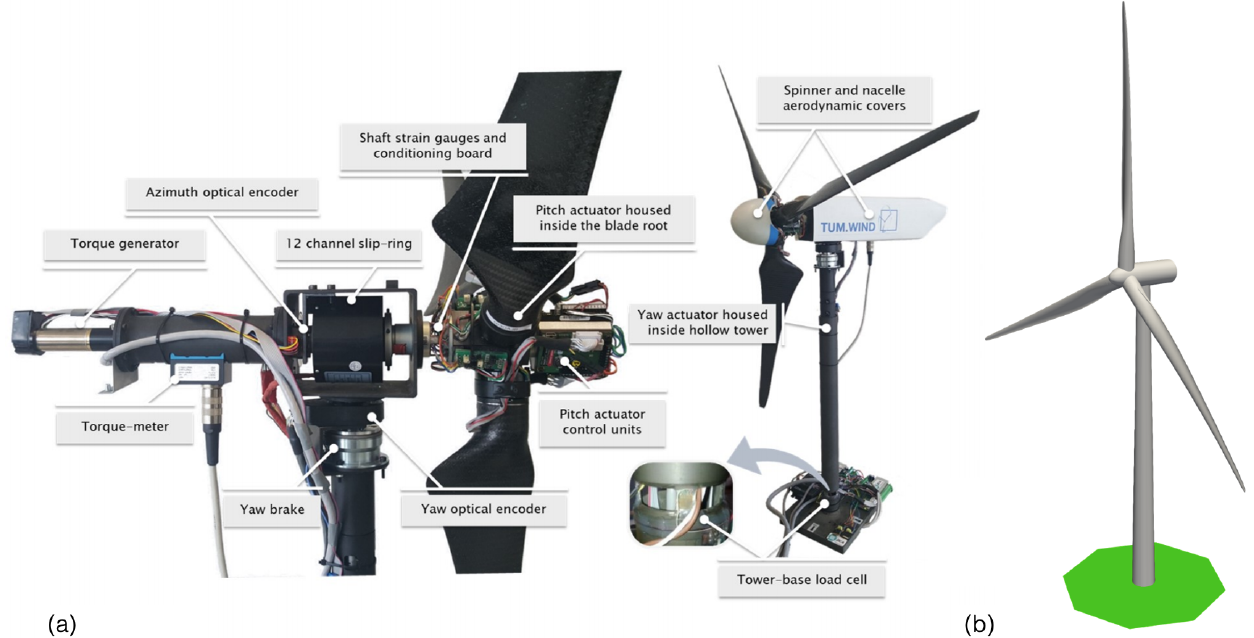
Figure 1. (a) The TUM G1 turbine (Campagnolo et al., 2016). (b) The full-scale DTU 10MW turbine (from Bak et al., 2013).